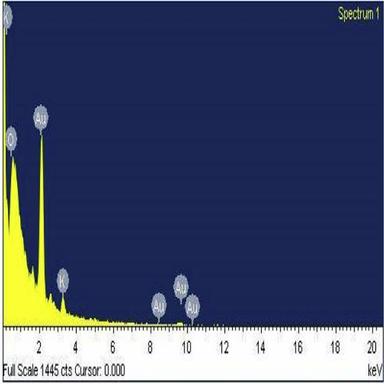
EDX spectrum of AuNPs synthesized using Lonicera japonica flower extract.